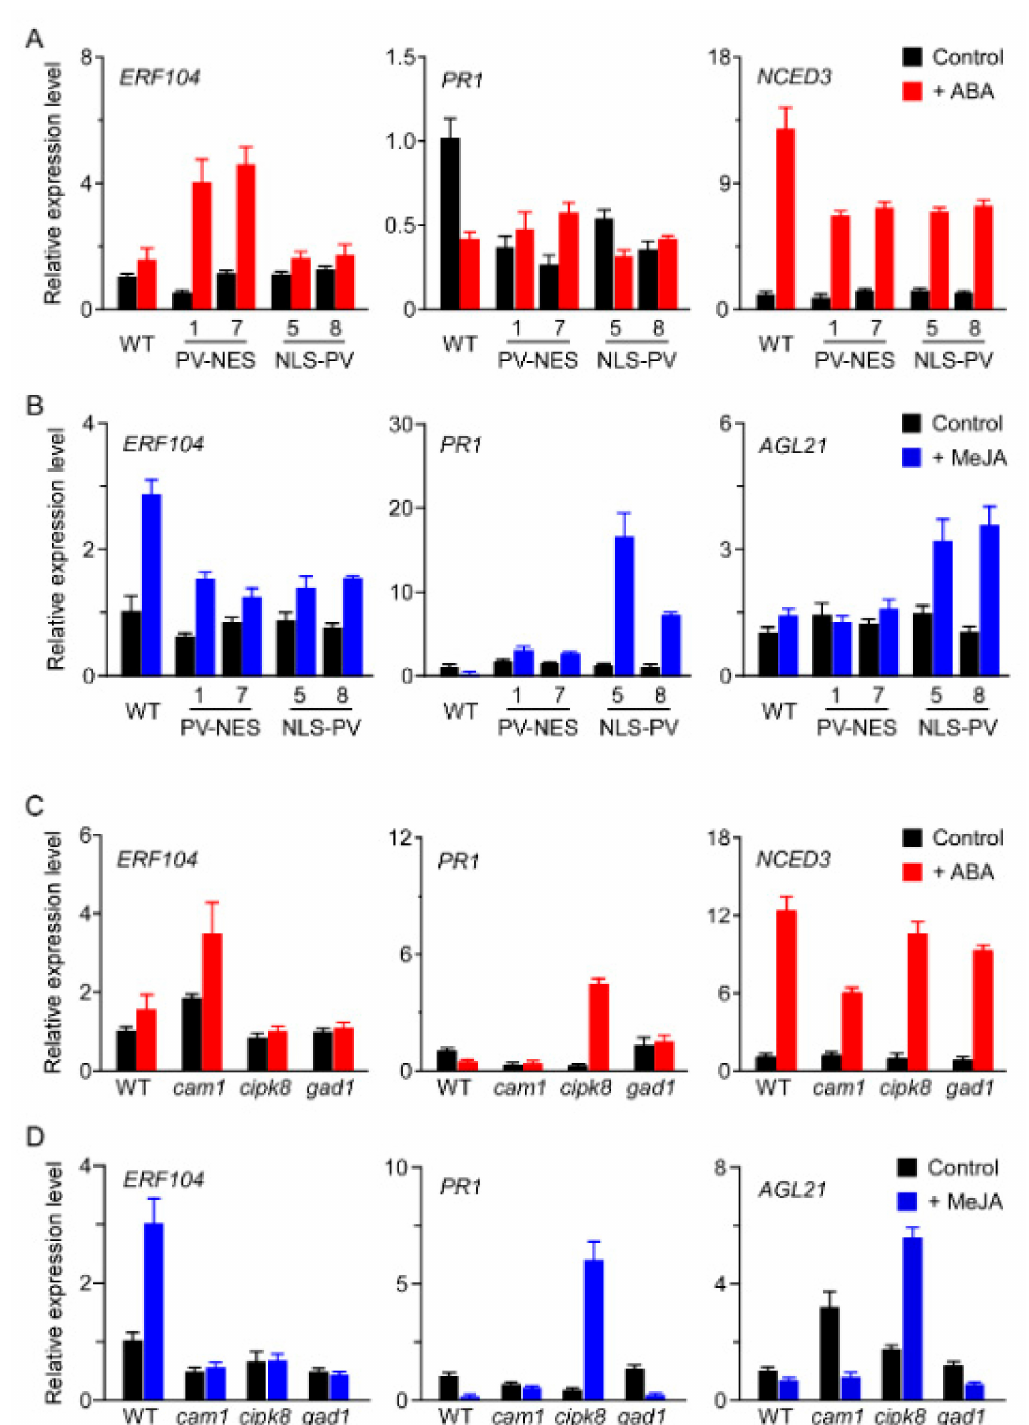
Figure 6. Expression patterns of several [Ca 2+ ]-regulated genes were detected by qRT-PCR in A . thaliana seedlings. ( A , B ) Transcript abundances of ERF104 , PR1 , and NCED3 in response to ABA (10 µ M) or MeJA (50 µ M) in WT, PV-NES , and PV-NLS seedlings. ( C , D ) Transcript abundances of ERF104 , PR1 , and NCED3 in response to ABA (10 µ M) and abundances of ERF104 , PR1 , and AGL21 in response to MeJA (50 µ M) in WT, cam1 , cipk8 , and gad1 seedlings. Expression levels of target genes were normalised to the expression level of actin2 , and the relative value of the WT was set to 1.0. Data are shown as means ± SDs of three biological